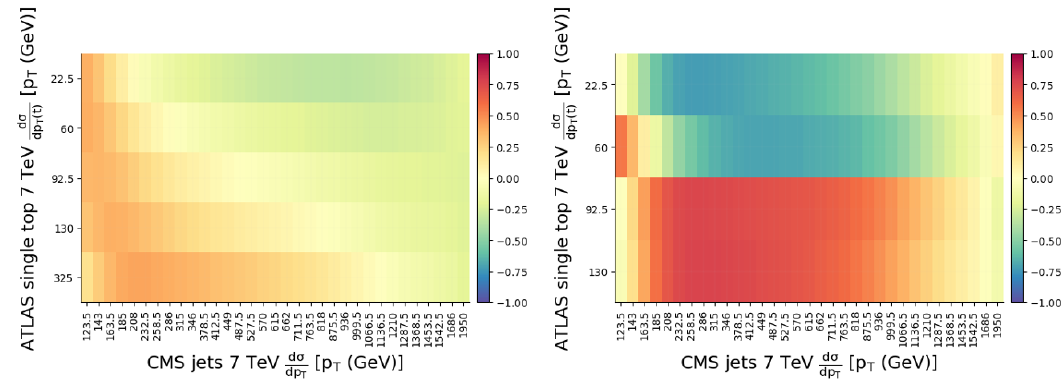
Figure 12 . The correlations between bins of the CMS 7 TeV inclusive jet dataset, which is binned in the p T of the jet, and both the ATLAS 7 TeV single top-quark p T absolute (left panel) and normalised (right panel) distributions. The CMS 7 TeV inclusive jet dataset is made up of (cid:12)ve separate distributions, each of which represents a di(cid:11)erent rapidity bin. One bin is shown here, which is for j y j < 0 : 5. These plots have been produced using theoretical predictions at NNLO in QCD with the NNPDF31 nnlo as 0118 PDF set and Q = m t = 172 : 5 GeV. The colour bar indicates the correspondence between (cid:26) and the colours in the